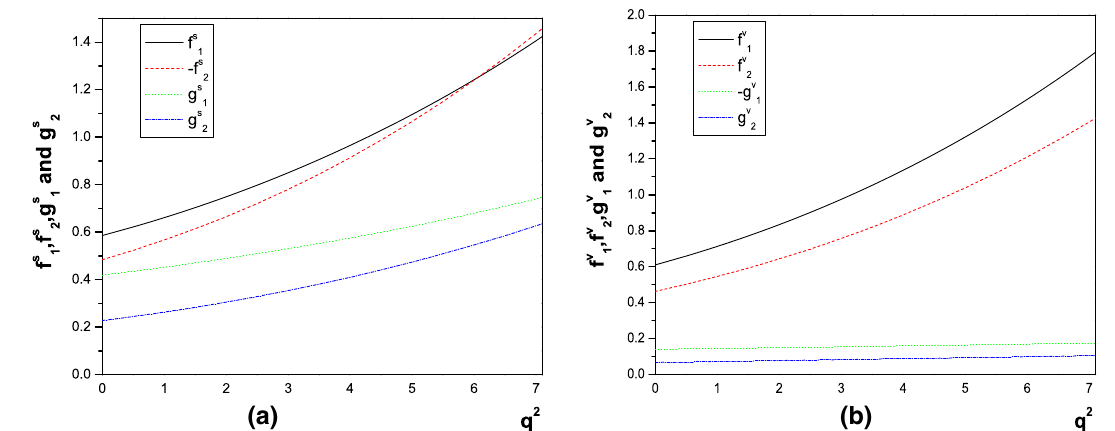
, f s , g s and g s in polynomial form on q 2 ( a ) and The dependence of form factors f v 1 2 1 2